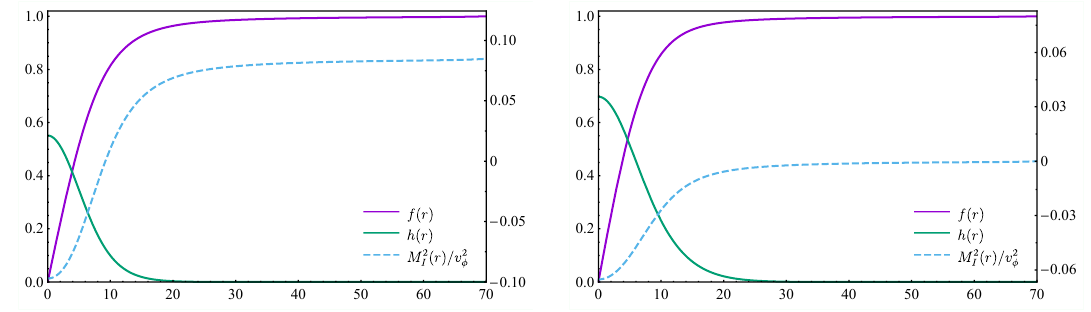
˜U(1) model. The mass Figure 1 . Typical forms of the string profile functions in the U(1) × parameters are chosen as m = m (left) and m (right). The purple and green solid lines φ σ φ (cid:29) m σ show the profiles of Φ and Σ , respectively, and their values are indicated by the left vertical axis. The blue dashed line means the position-dependent mass M 2 ( r ) of the imaginary part of Σ , whose I values are indicated by the right vertical axis (see section 3 for the